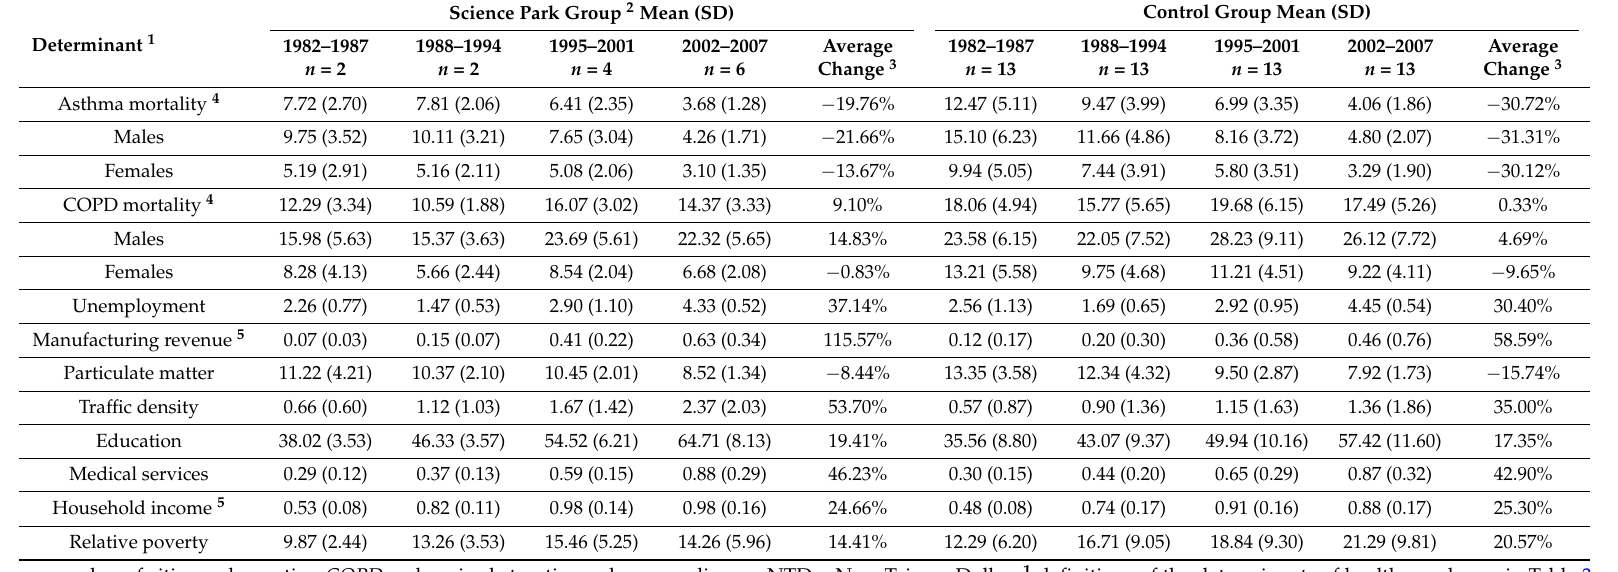
Table 4. Averaged means and standard deviations (SDs) for city- and county-level respiratory mortality rate and its determinants, 1982–2007.